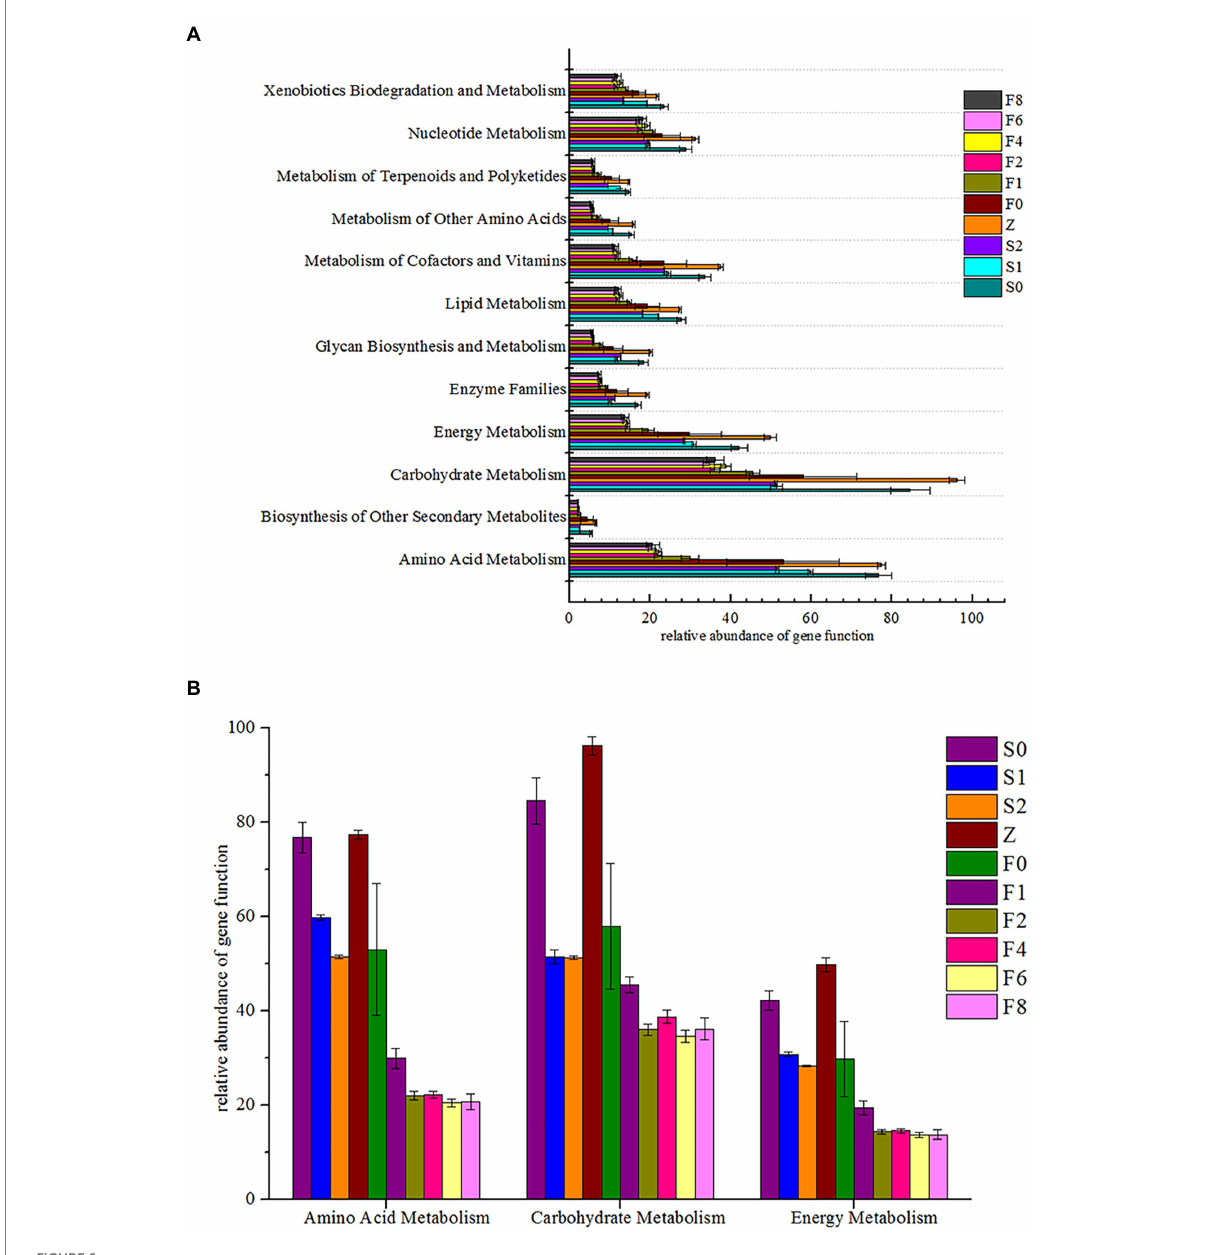
FIGURE 6 Functional genes related to metabolism. (A) distribution of KEGG pathways, (B) amino acid metabolism, carbohydrate metabolism and energy